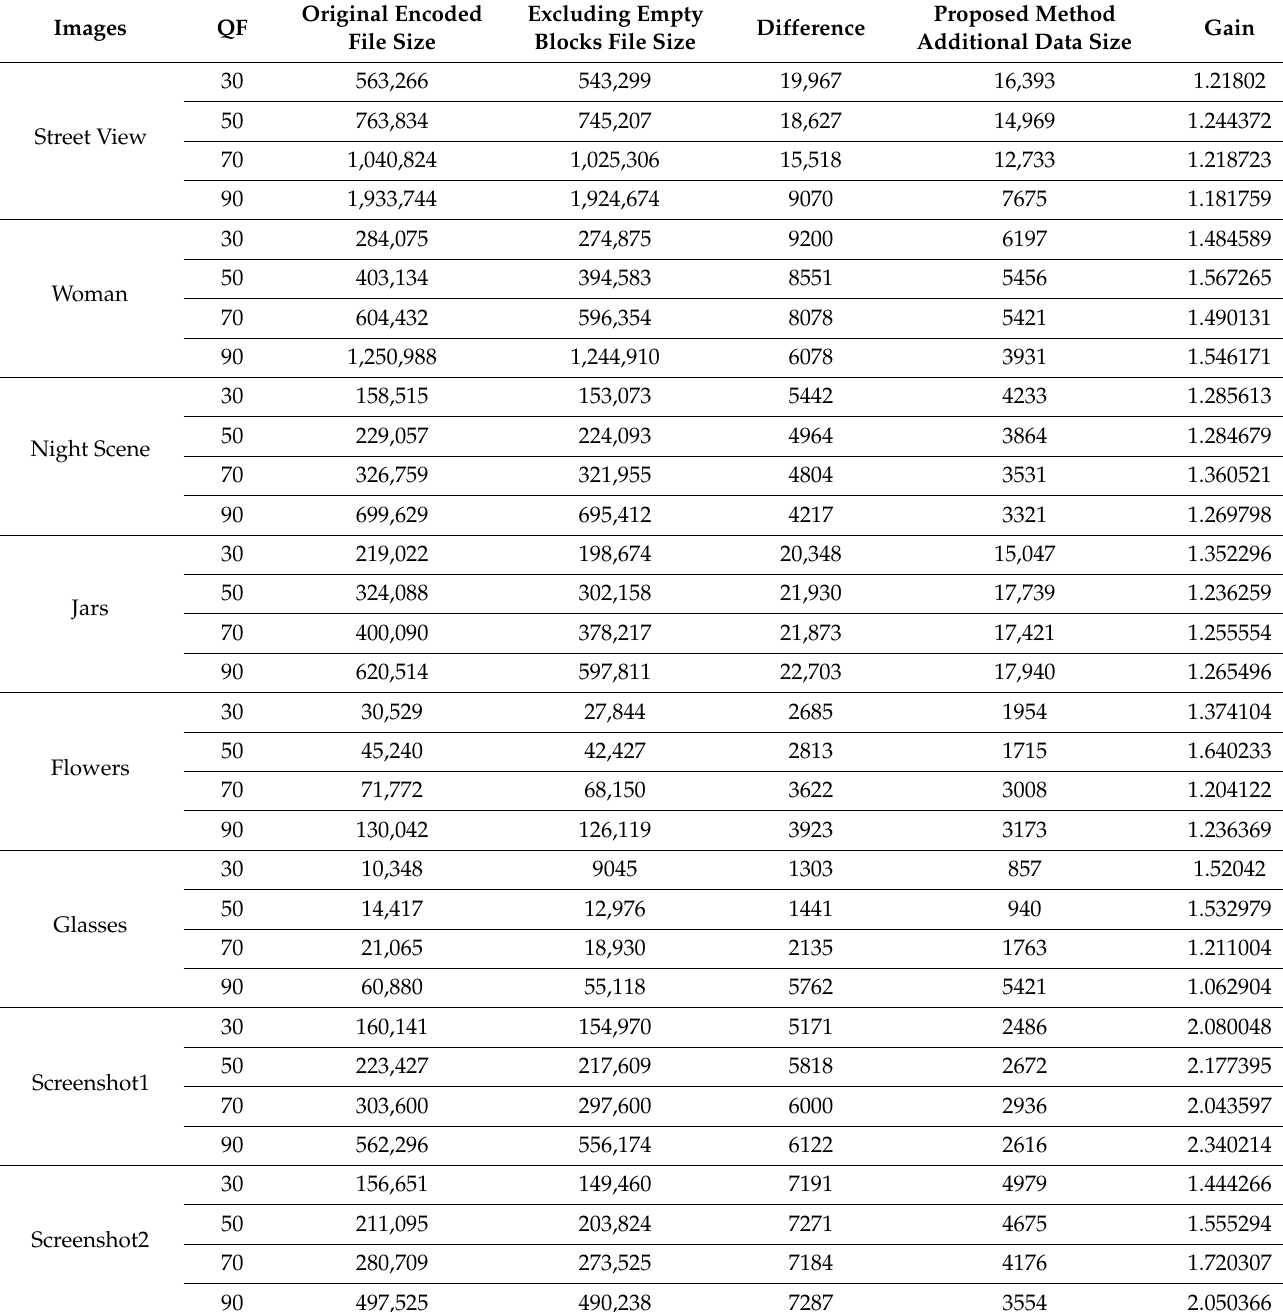
Table 3. Encoded images file size information for arithmetic encoding